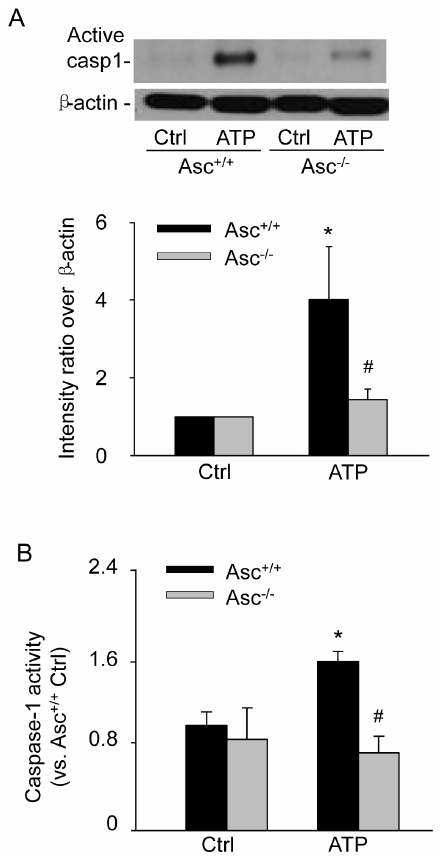
Figure 4. Asc gene knockout inhibited ATP-induced caspase-1 activation in BMMs. (A) Western blot analysis showing the effect of ATP (2.5 mM, 16 h) on active caspase-1 expression and the quantitative analysis (lower blot). (B) Summarized data of FLICA assays quantifying the relative caspase-1 activity compared to control. * P , 0.05 vs . untreated Asc + / + control group; # P , 0.05 vs . Asc + / + ATP group (n=6).